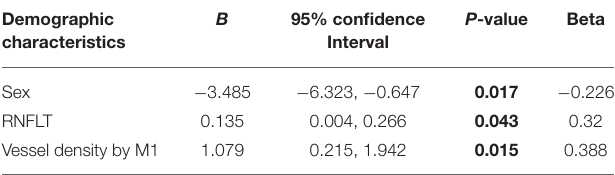
TABLE 5 | Factors associated with visual field mean